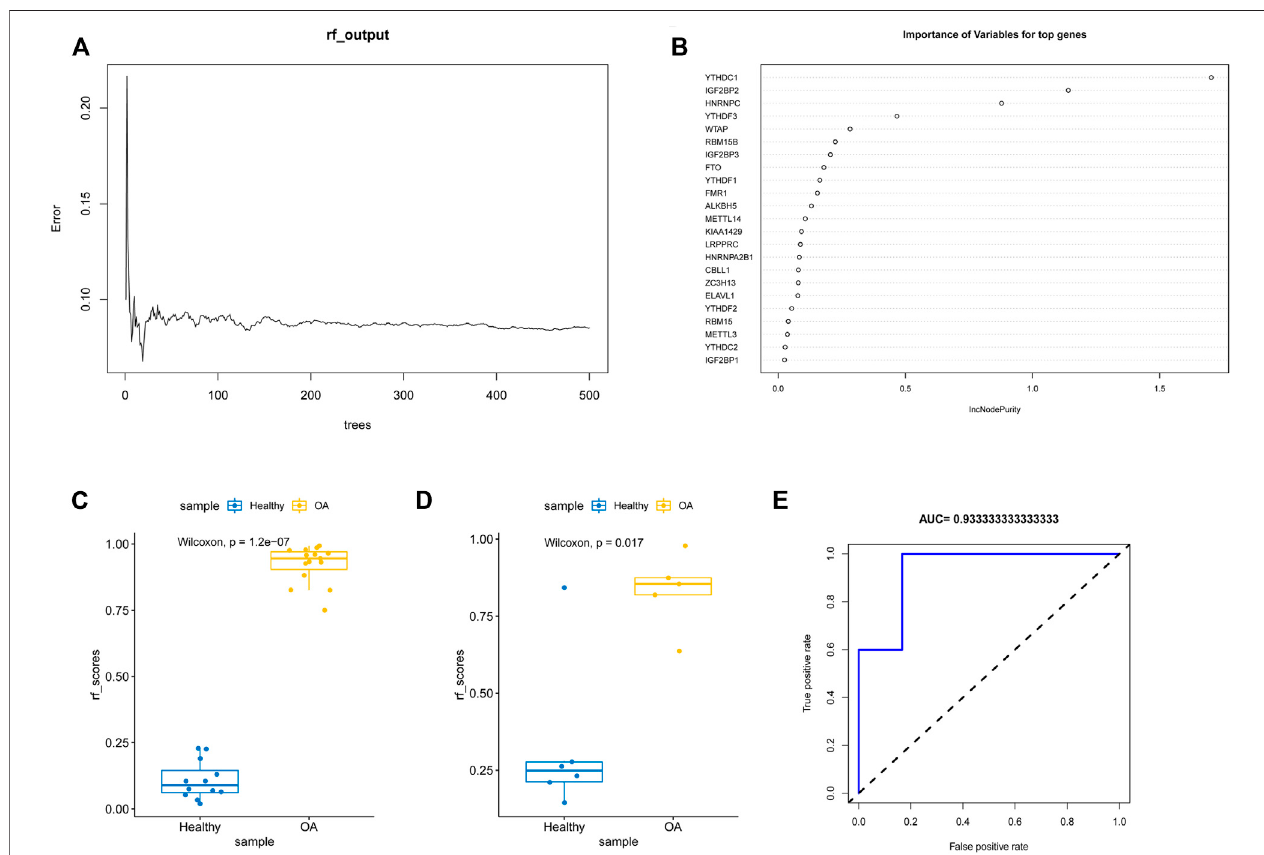
FIGURE4| Random forest analysis. (A,B) Them6Agenewasmodeledbyrandomforest. (C,D) Boxplotsofratingsfortraining andvalidation sets. (E) ROCplotof random forest diagnosis.